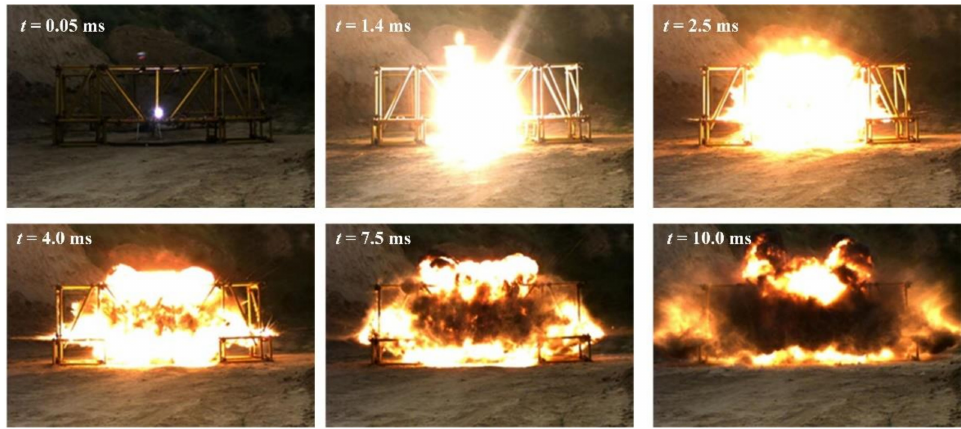
Figure 4. The explosion process without explosion height.